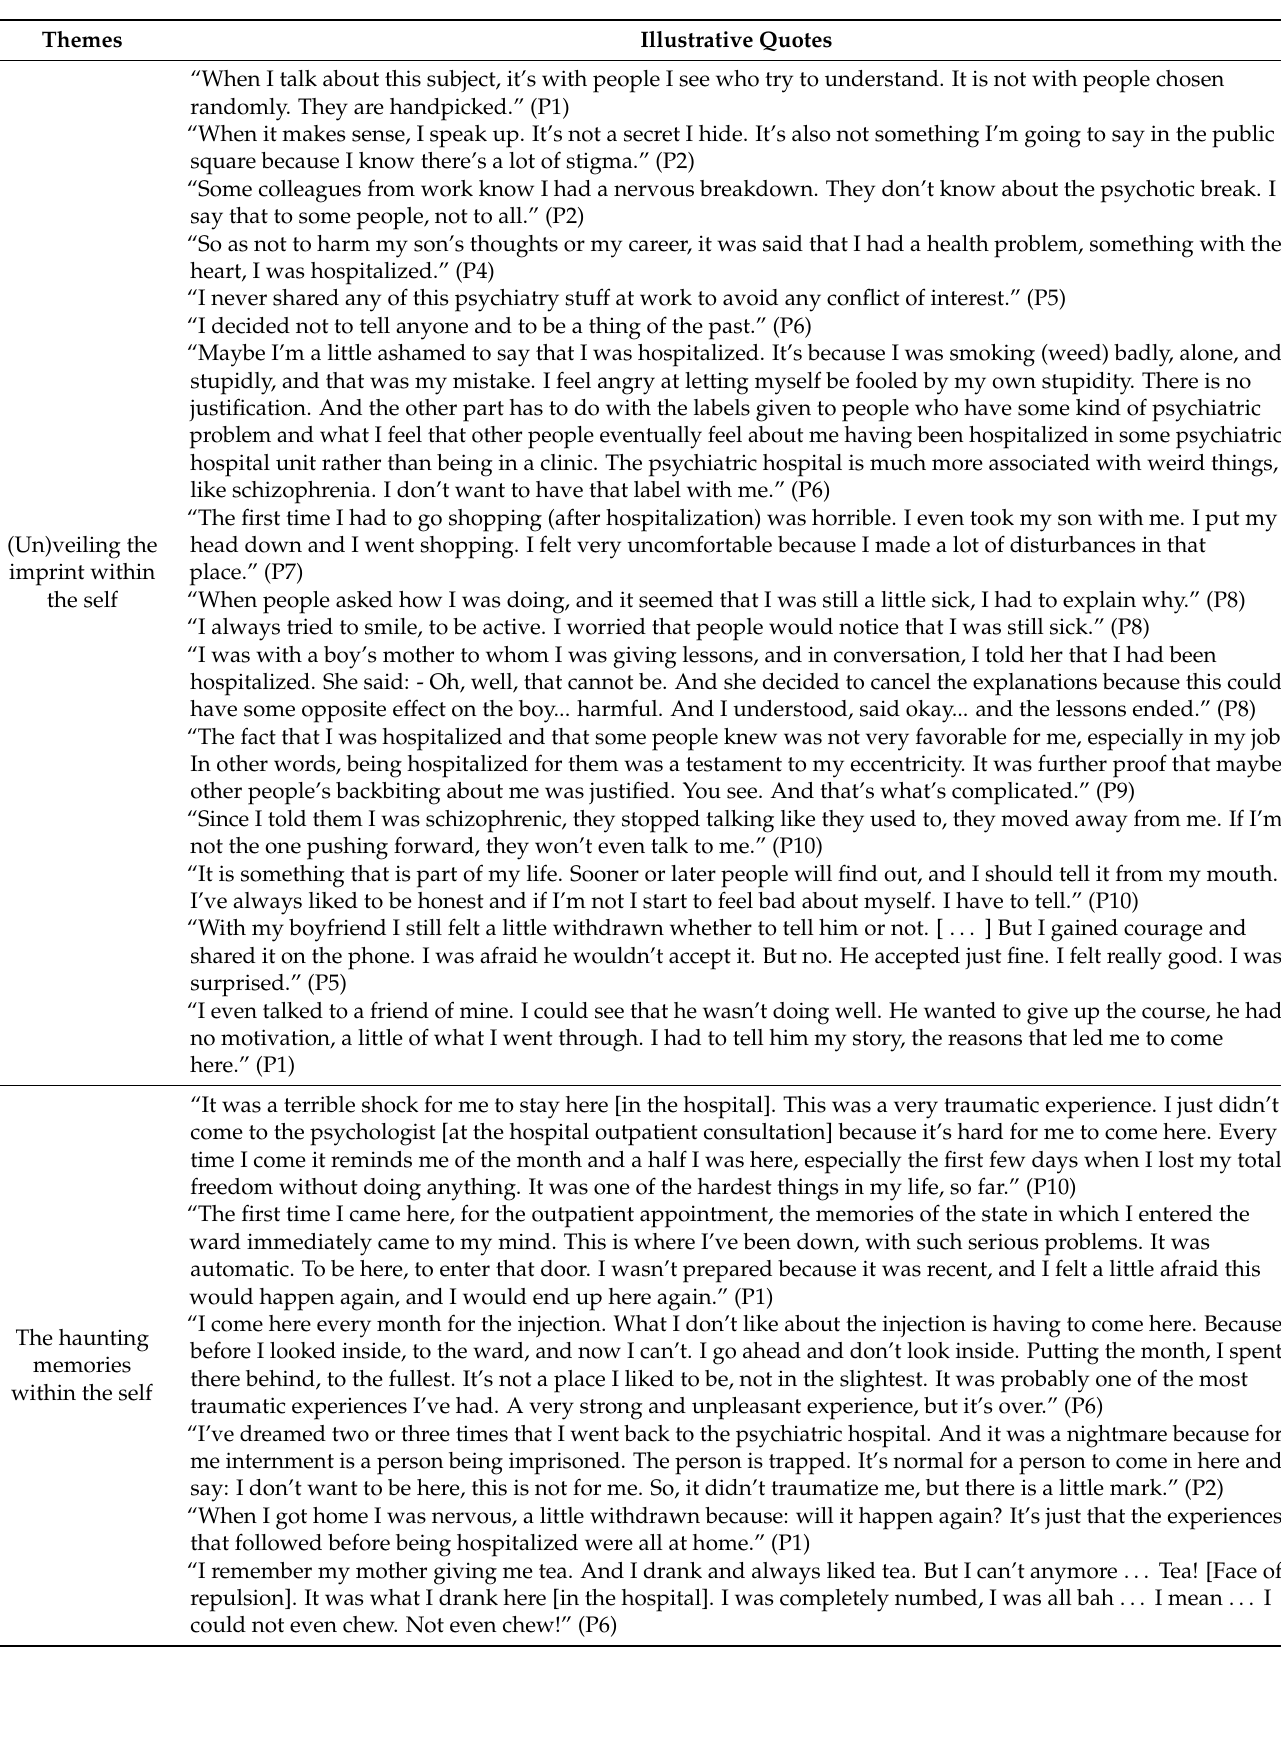
Table 1. Illustrative quotes for themes regarding the constitutive pole of the